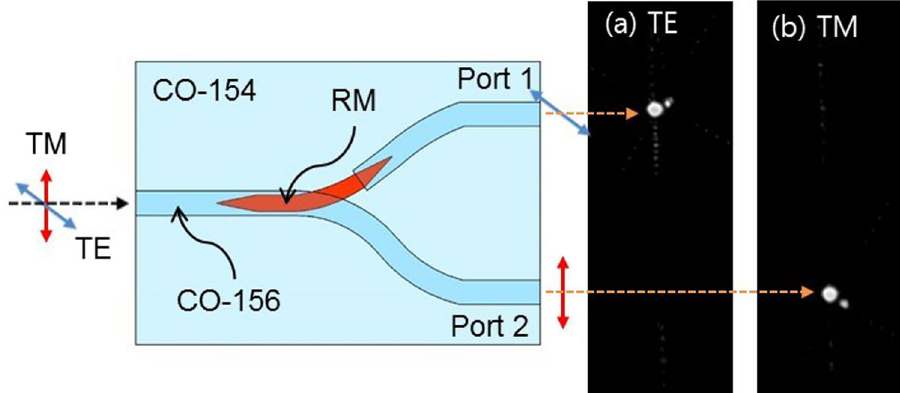
Figure 3. CCD images of the output modes for the inputs with ( a ) TE polarization, and ( b ) TM polarization, in which a crosstalk to the other output port is negligible.